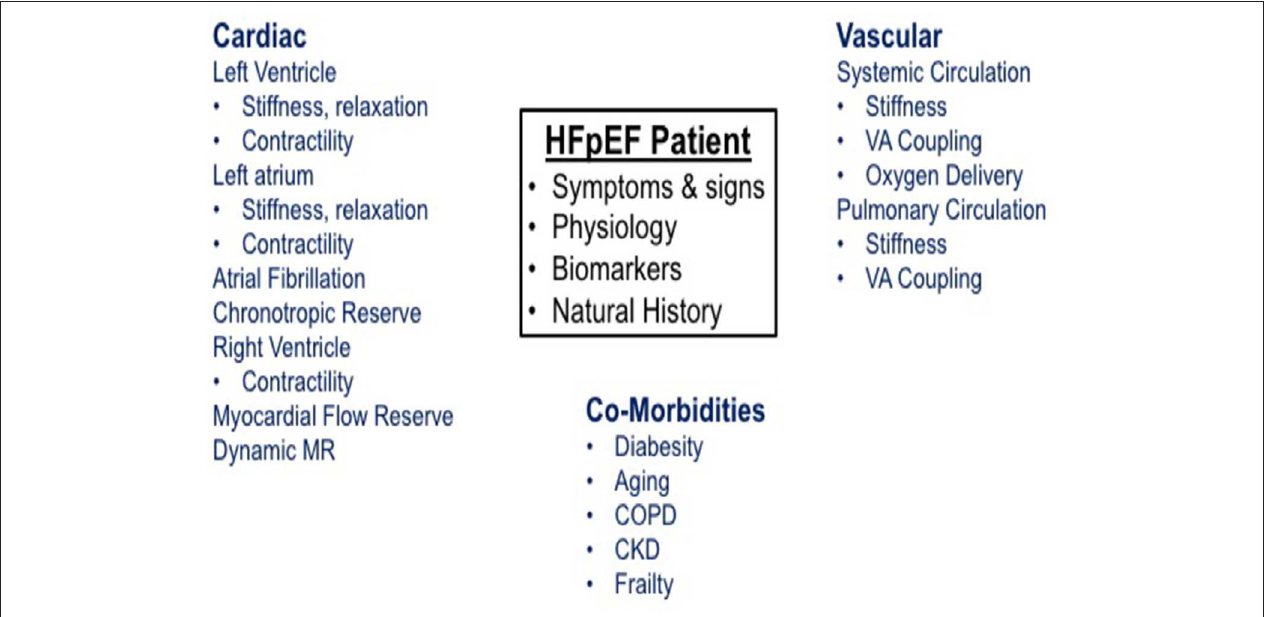
FIGURE 1 | Schematic represents the pathophysiology of heart failure with preserved ejection